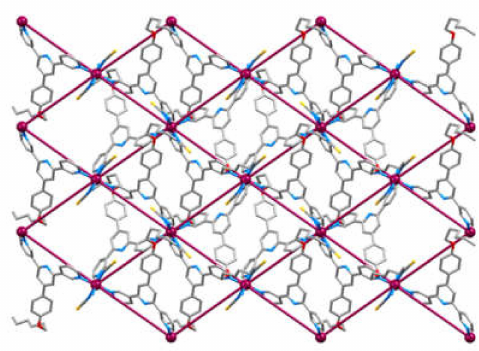
Figure 7. Part of one (4,4) net in [Co( 6 ) 2 (NCS) 2 ] n with the net defined by the lines connecting the Co atoms; H atoms are omitted.